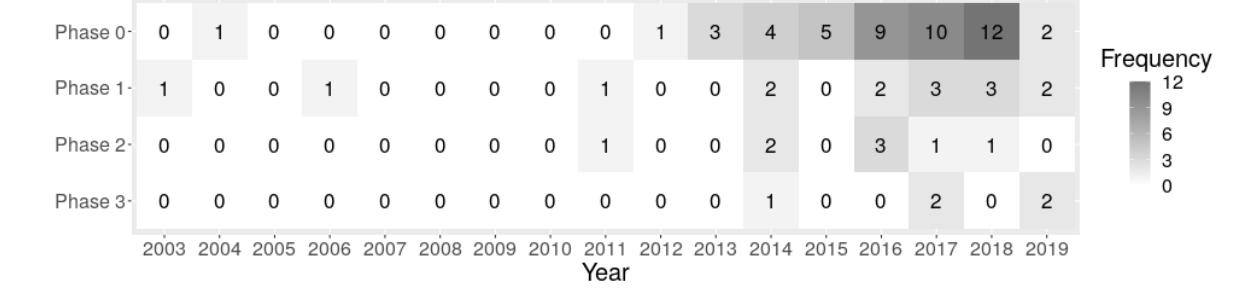
Significant effectiveness or efficacy is evaluated in phase 3